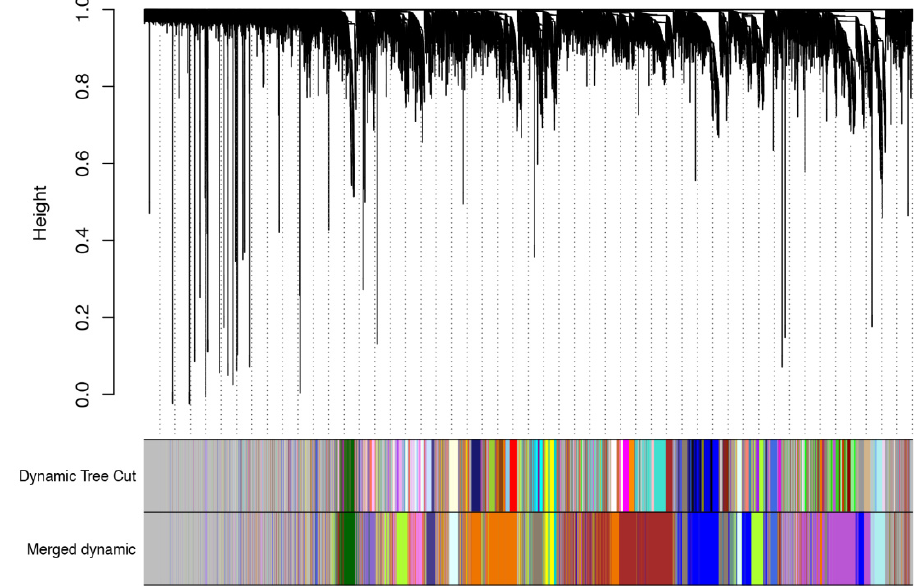
Figure 7. WGCNA co-expression analysis of 27 rice samples. The upper panel shows gene clusters based on their expression patterns. Genes that cluster in the same clade share a similar expression pattern. The gene clusters are further indicated using different colors in the lower